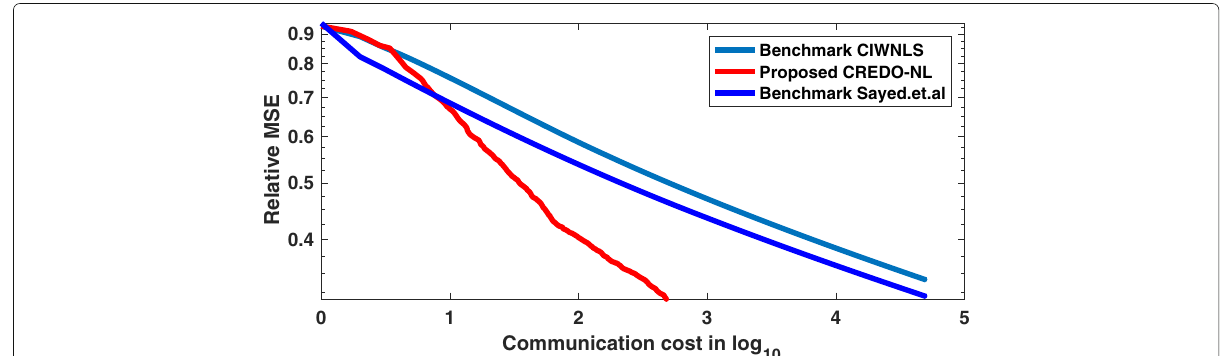
Fig. 3 Comparison of the proposed and benchmark estimators in terms of relative MSE: Communication Cost Per Node. The light blue line represents the CIWNLS algorithm, the dark blue line represents the diffusion-based algorithm proposed in [43], and the red line represents the proposed